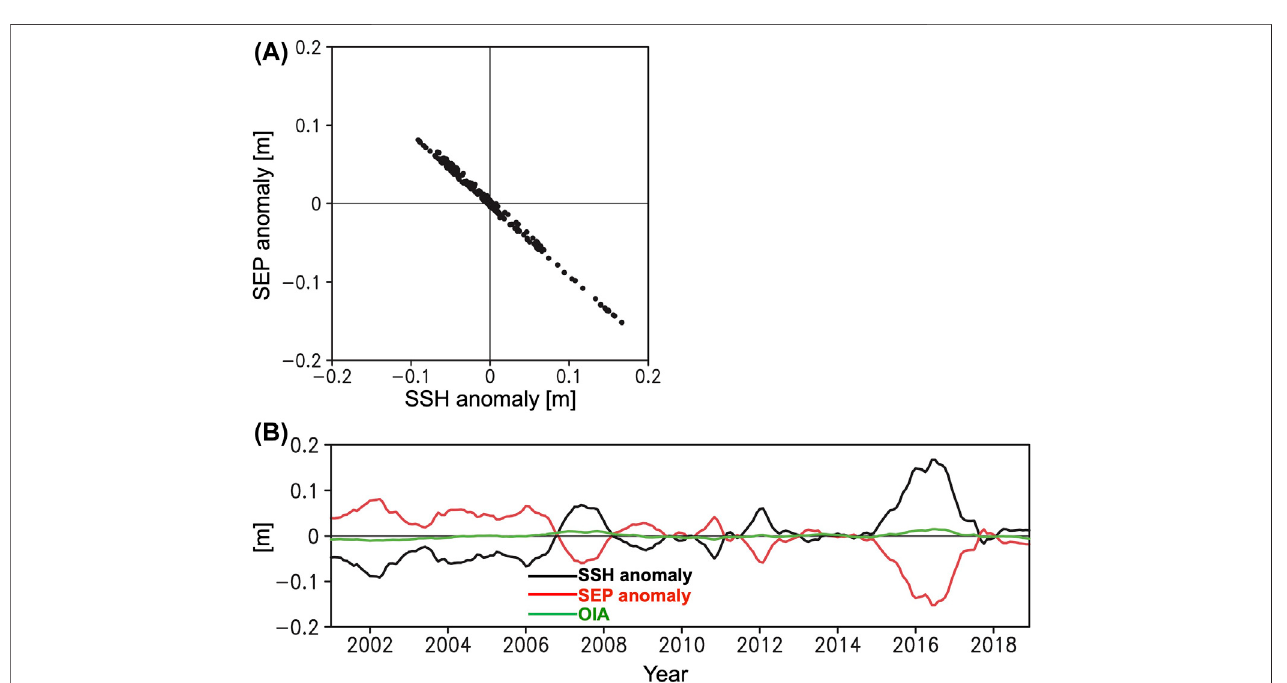
FIGURE8|(A) ScatterplotsbetweenSSH and SEPanomaliesat theclosestgrid pointtoPG1fortheperiod fromJanuary2001toDecember 2018.Theunit ism. (B) Timeseries of the SSH anomaly (black thick solid line), SEP anomaly (red thick solid line), and OIA (green thick solid line) at PG1. The unit is m.